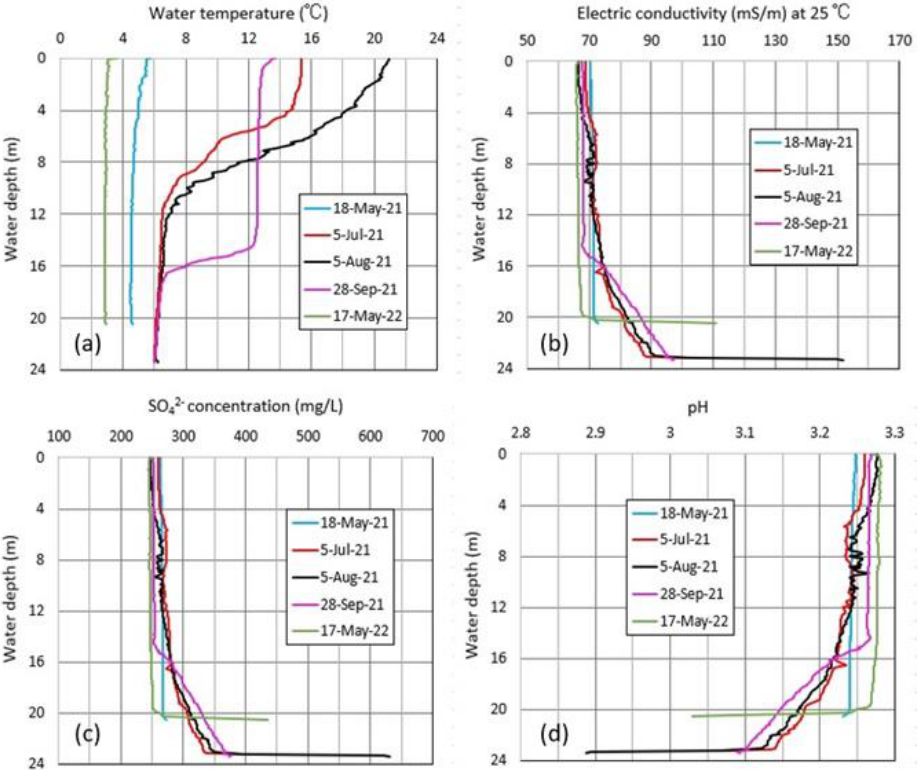
Figure 9. Vertical distributions of ( a ) water temperature, ( b ) electric conductivity at 25 °C (EC25), ( c ) SO 42 − concentration, and ( d ) pH at site MD in May 2021 – May 2022.